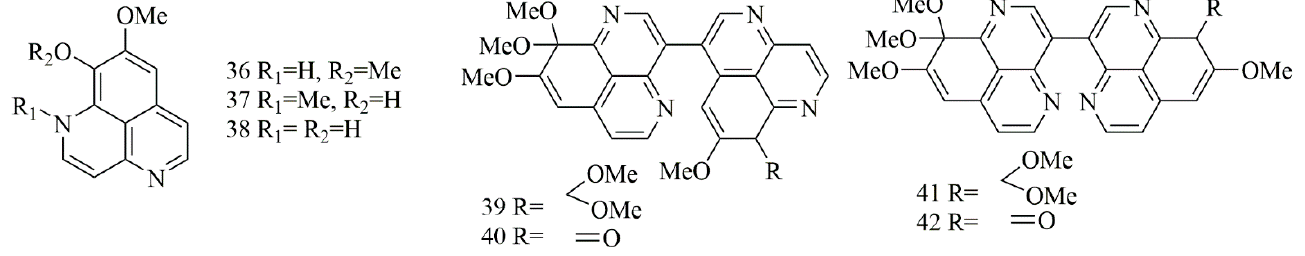
Figure 5. Dimeric aaptamine alkaloids from marine sponges. Table 5. Cytotoxic activity of Dimeric aaptamine alkaloids.